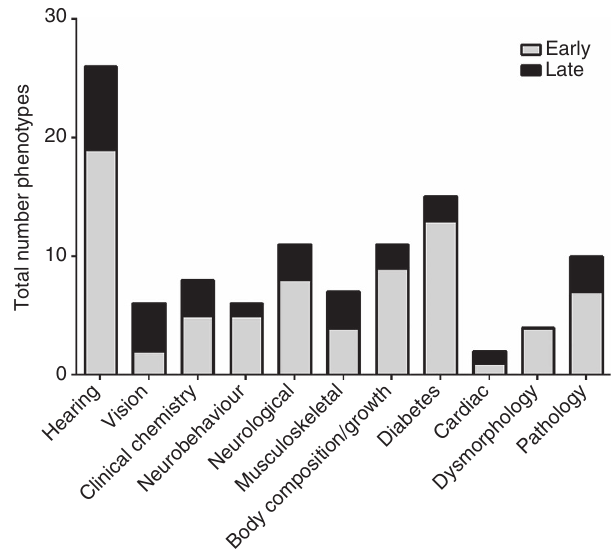
Figure 2 | The distribution of early and late phenotypes across a variety of disease and biological categories. A histogram of the distribution of early and late phenotypes across different phenotypic categories. Late